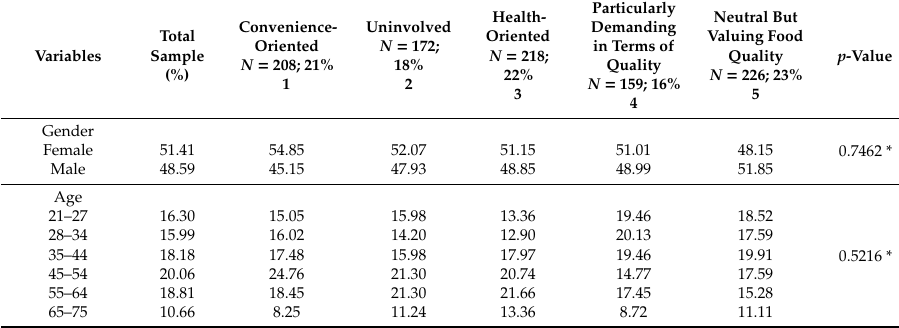
Table 2. Socio-demographic characteristics of the consumers surveyed ( N = 983, Poland)